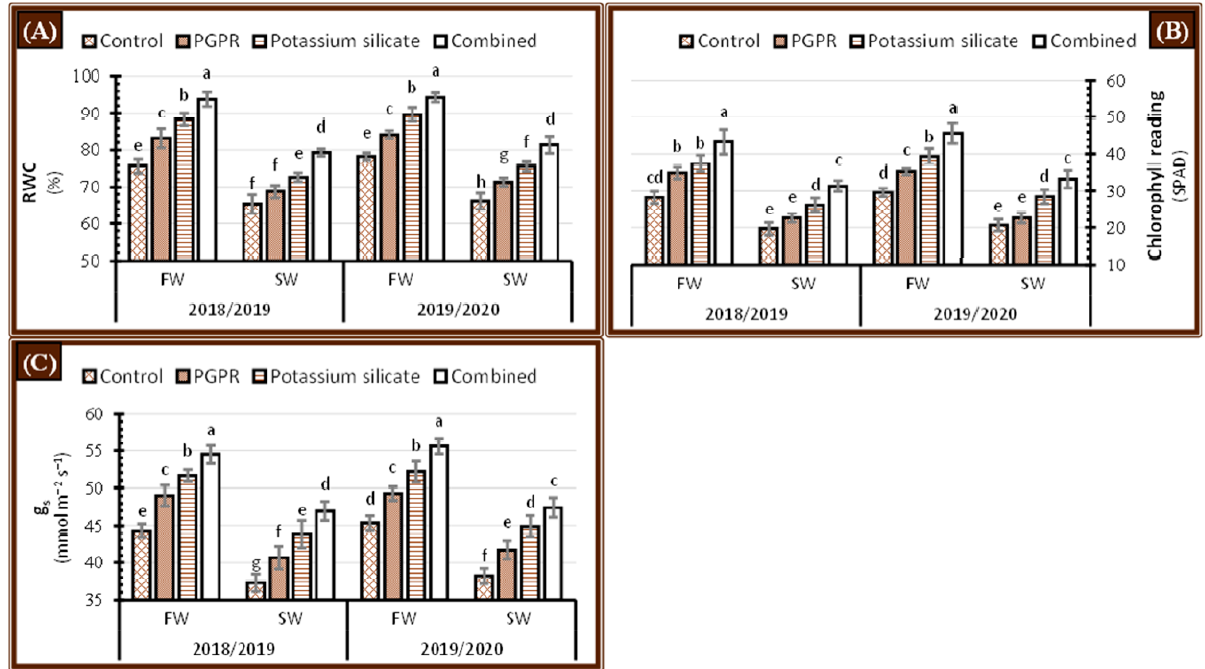
Figure 6. Effect of application of PGPR, potassium silicate and their combination on physiological attributes, i.e., ( A ) relative water content (RWC), ( B ) chlorophyll reading (SPAD), and ( C ) stomatal conductance (g s ) in leaves of faba bean plants growing under two irrigation types, i.e., fresh water (FW) and saline water (SW) in salt-affected soil during two growing seasons 2018/2019 and 2019/2020. The data are means ± SD of four replicates. Means values that have the same lower-case letter in each column per season are not significant according to Duncan’s Multiple Range